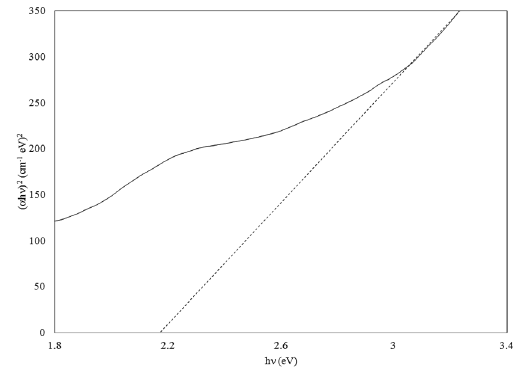
Figure 4: UV-vis diffuse reflectance spectra and plot ( αhv ) 2 vs. photon energy (inset).